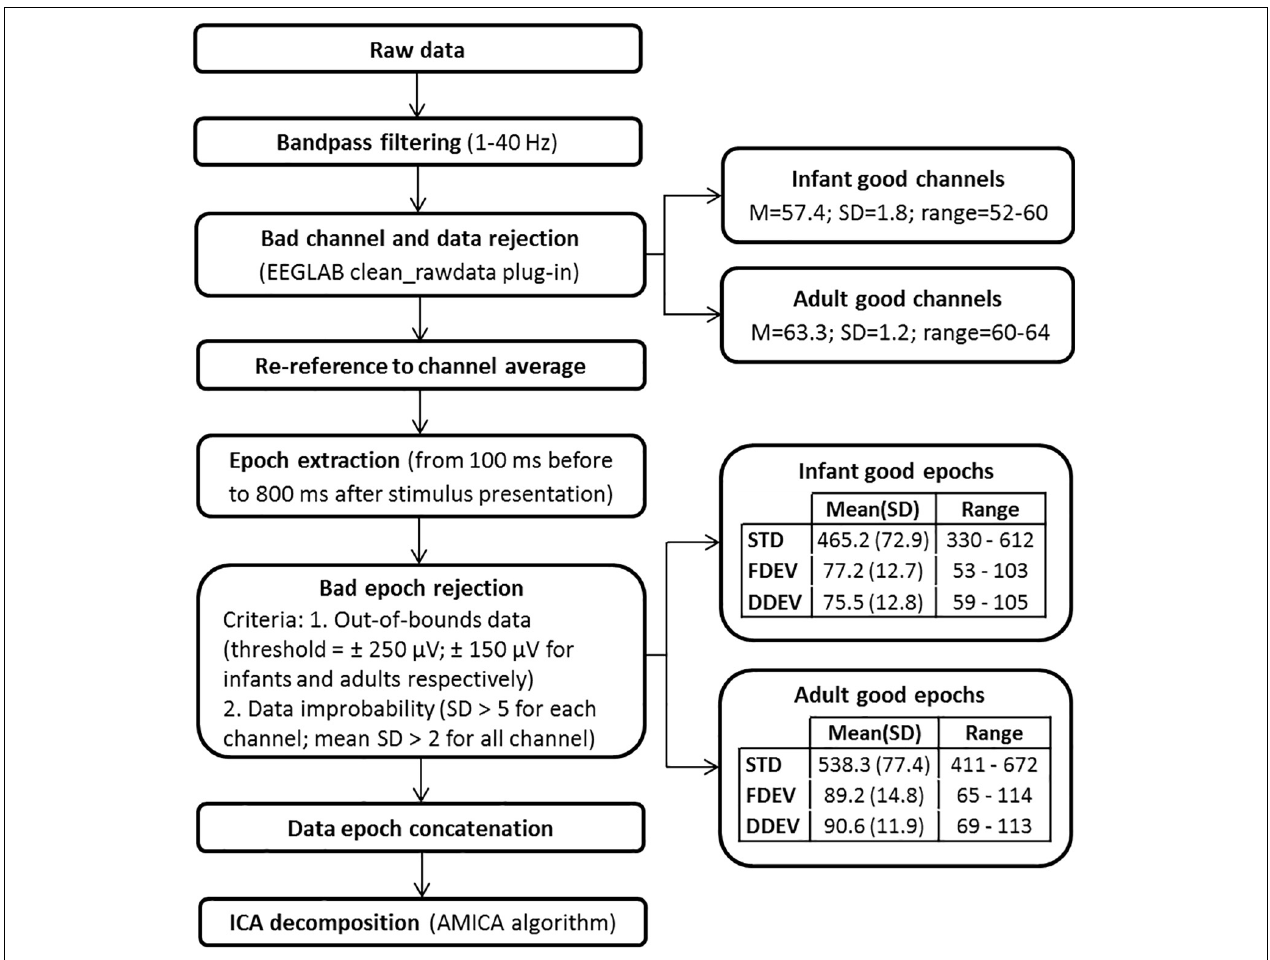
FIGURE 2 | Data preprocessing